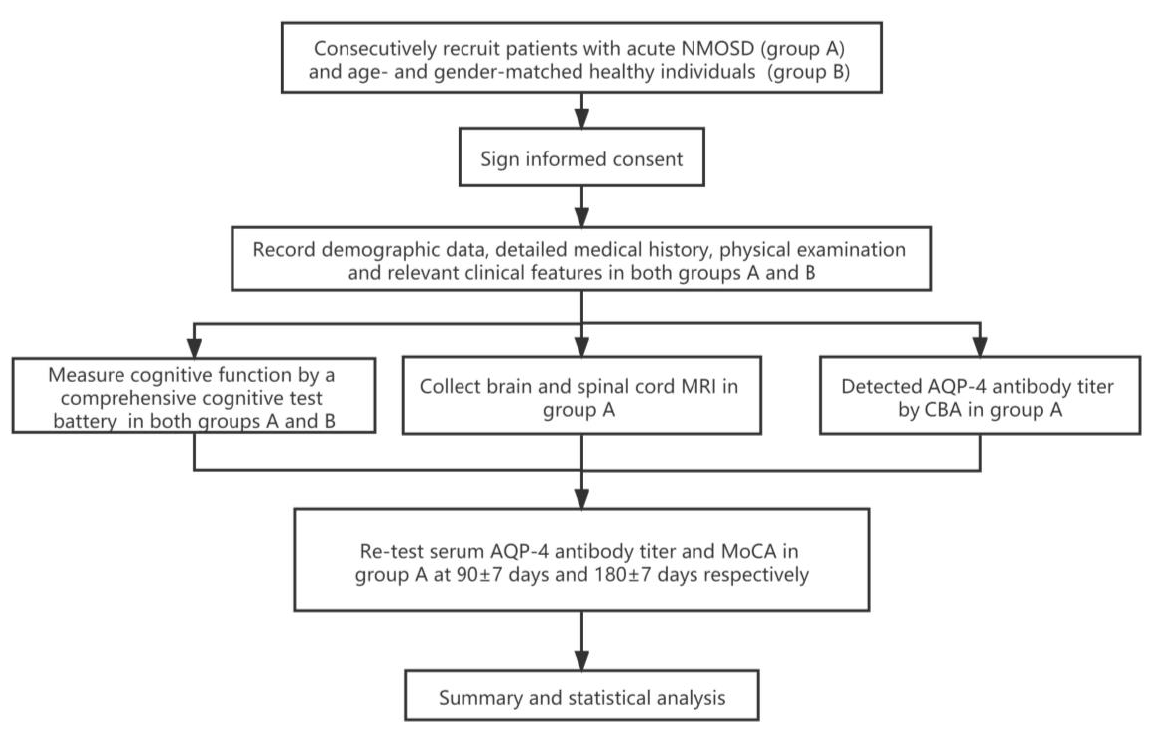
Figure 1. Trial profile. NMOSD: neuromyelitis optica spectrum disorders; AQP-4: aquaporin-4; CBA: cytometric bead array; MoCA: Montreal Cognitive Assessment. Table 1. Cognitive evaluation scales and their domains.